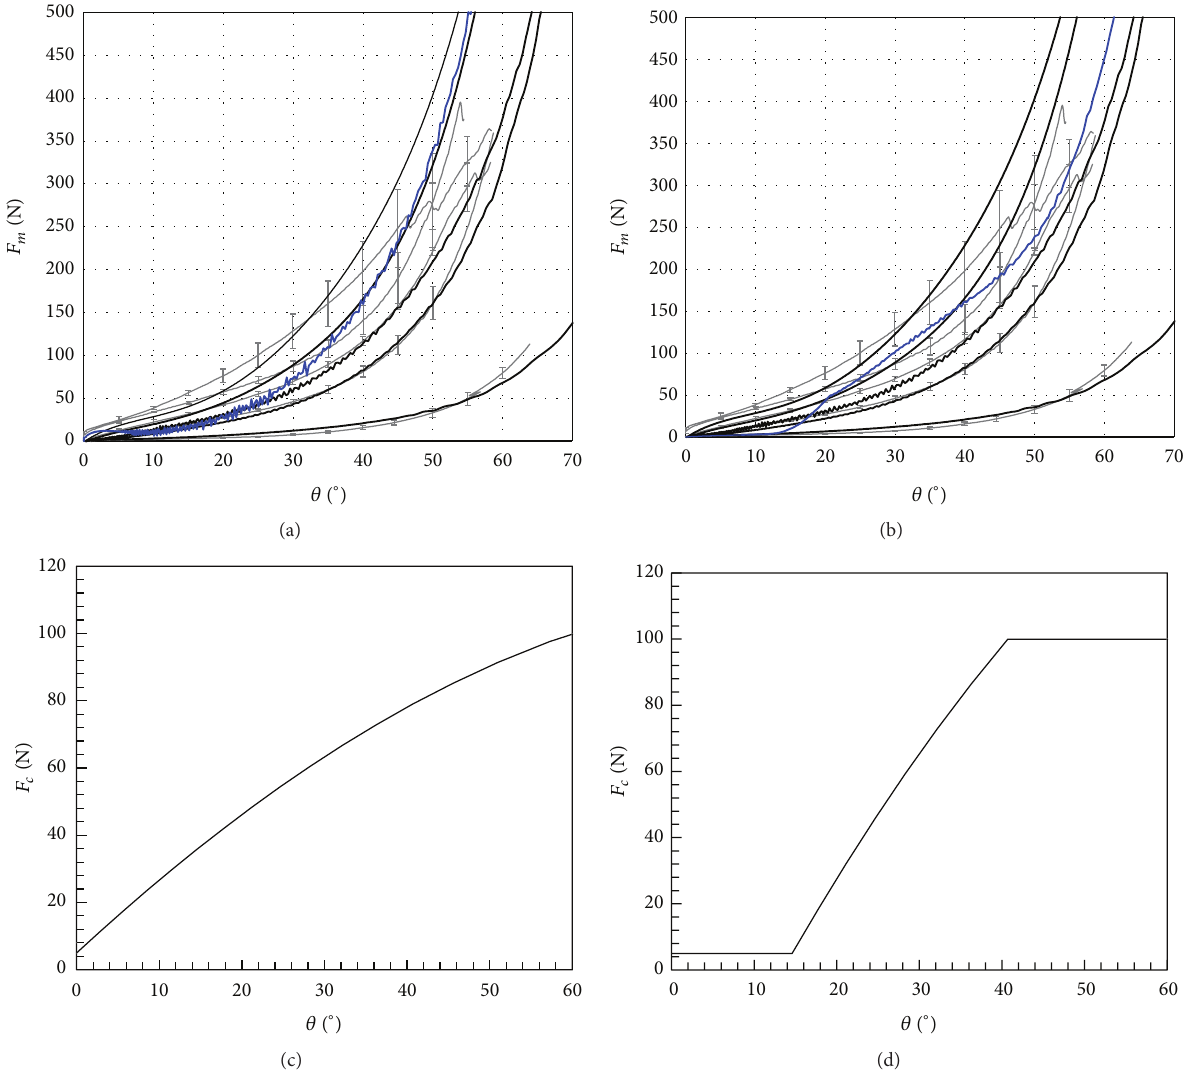
Figure 7: Evaluation of the coupled S-NOCM (a) and (b). The faint grey lines are the experimental results from [10], the black lines are the normalised predictions shown in Figure 6, and the blue lines are the predicted results when an increasing transverse load is applied to the sides of the specimen. The transverse loading profiles are profiles shown in (c) and (d),